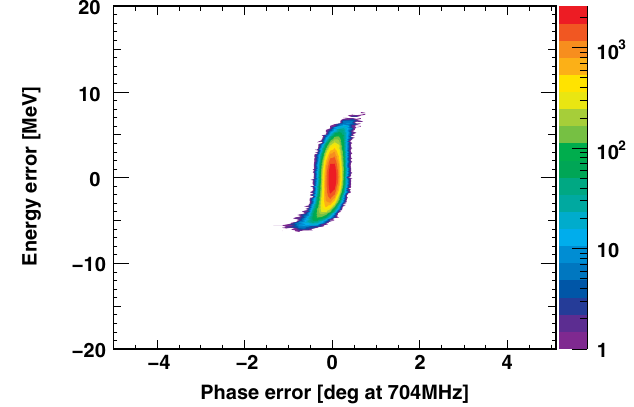
FIG. 4. 2D phase space histogram of one pulse at the end of the linac, which is not disturbed by HOMs. This distribution will be used as a reference later on. Settings: no HOM, N ¼ 1 , see